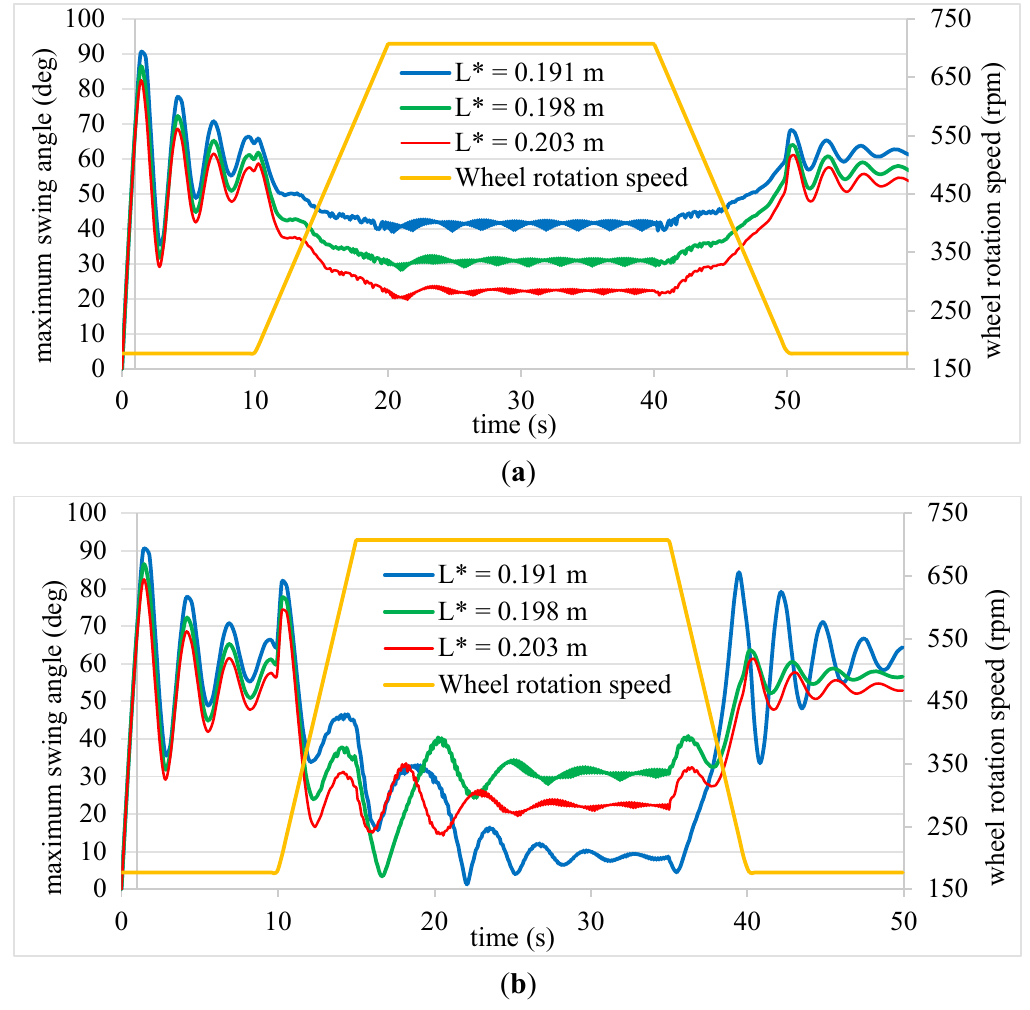
Figure 5. Maximum swing angle under various L * . ( a ) After angular acceleration of 73.7 rad/s 2 . ( b ) After angular acceleration of 148 rad/s 2